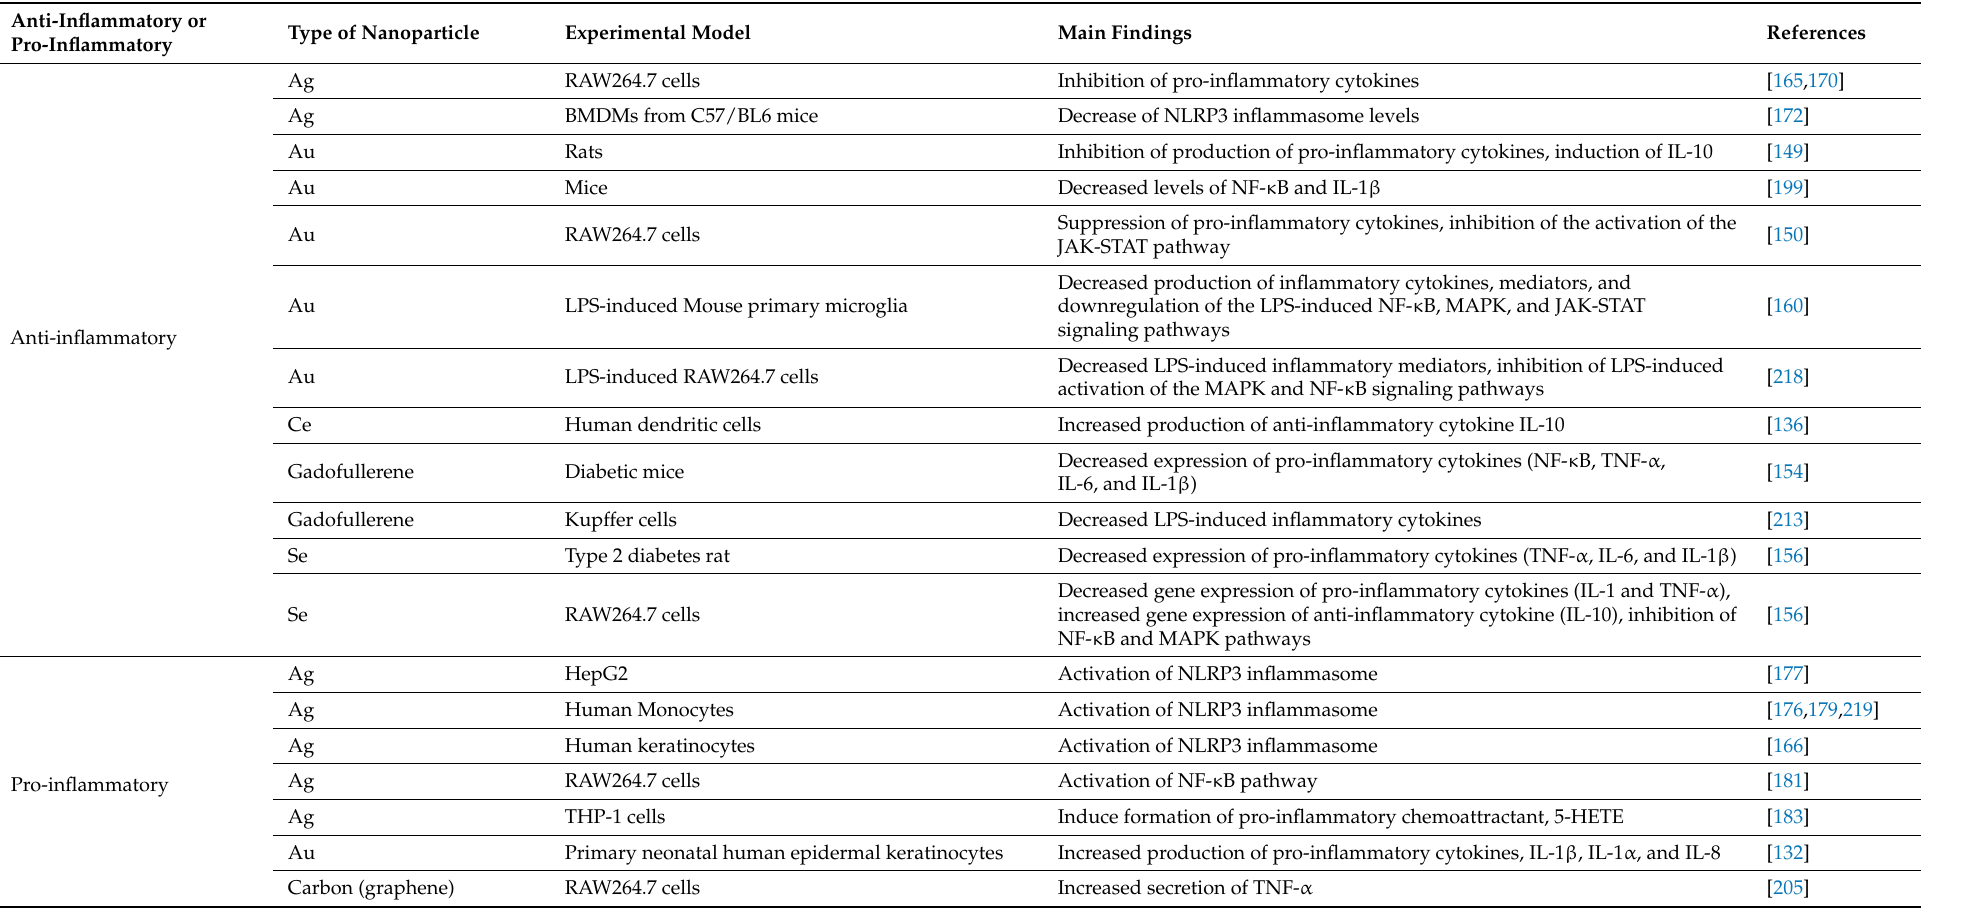
Table 4. Summary of the effects of various nanoparticles on inflammation in different experimental